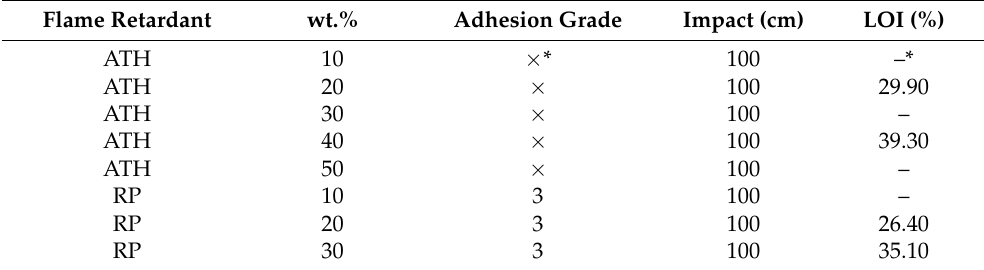
× * means the adhesion is too low to be measured; –* means the data is not